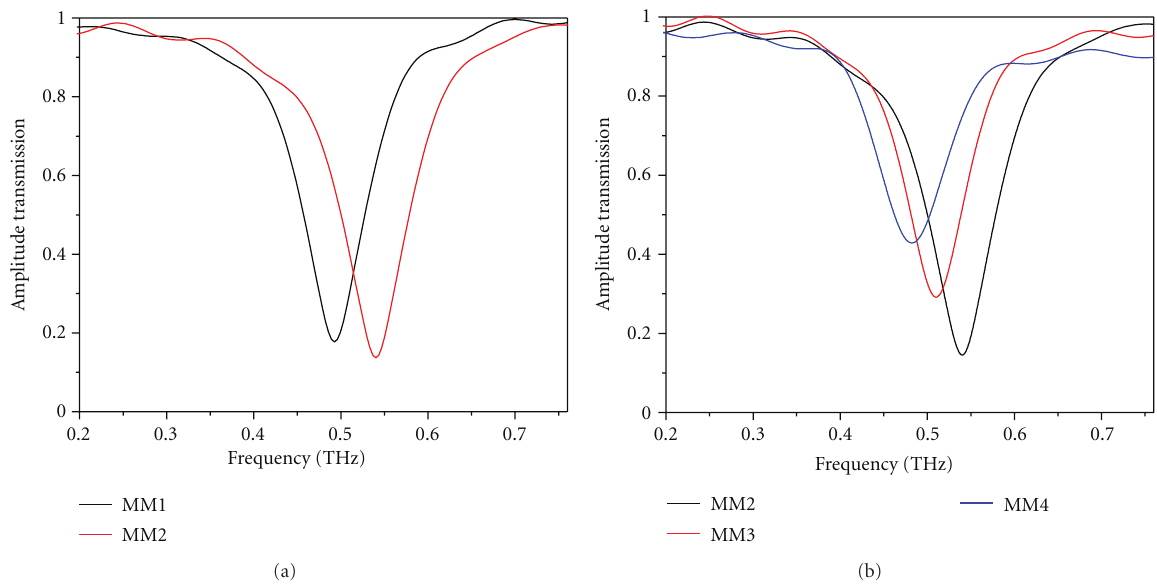
Figure 2: Measured THz electric field amplitude spectra when transmitting through the metamaterial samples for (a) MM1 and MM2 (b) and MM2, MM3, and